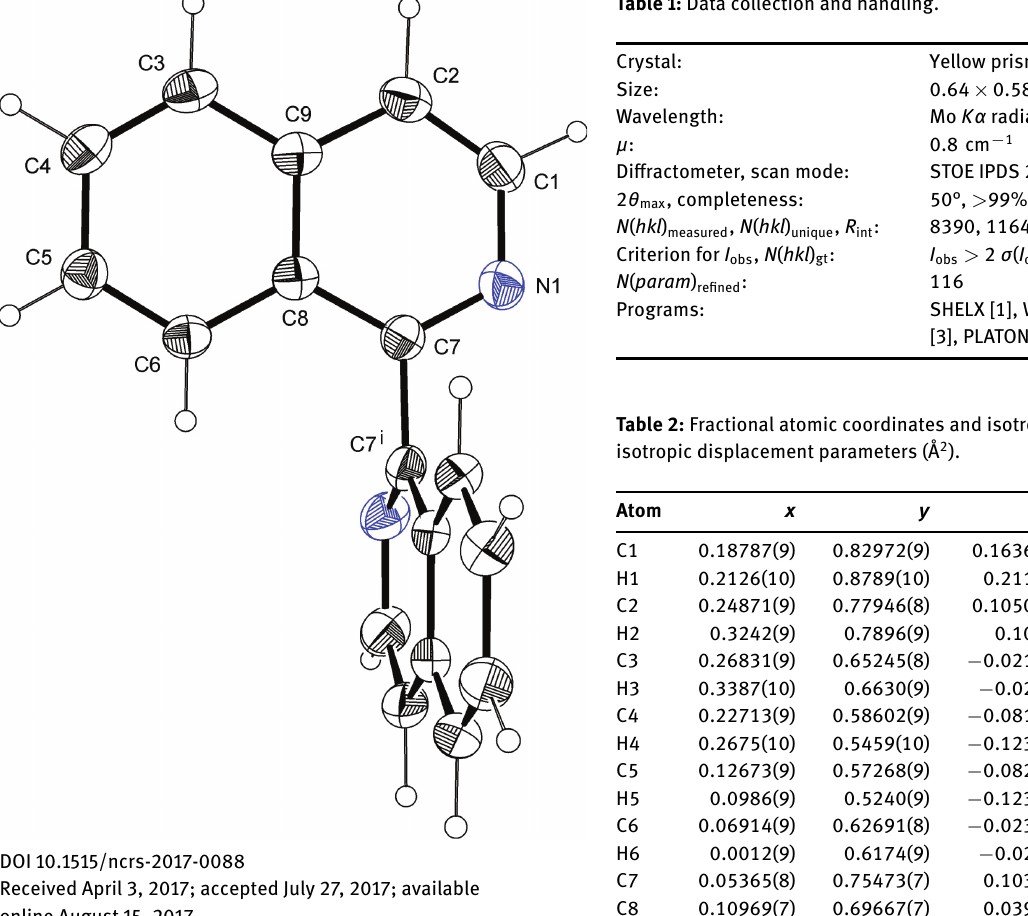
Table 1: Data collection and handling.